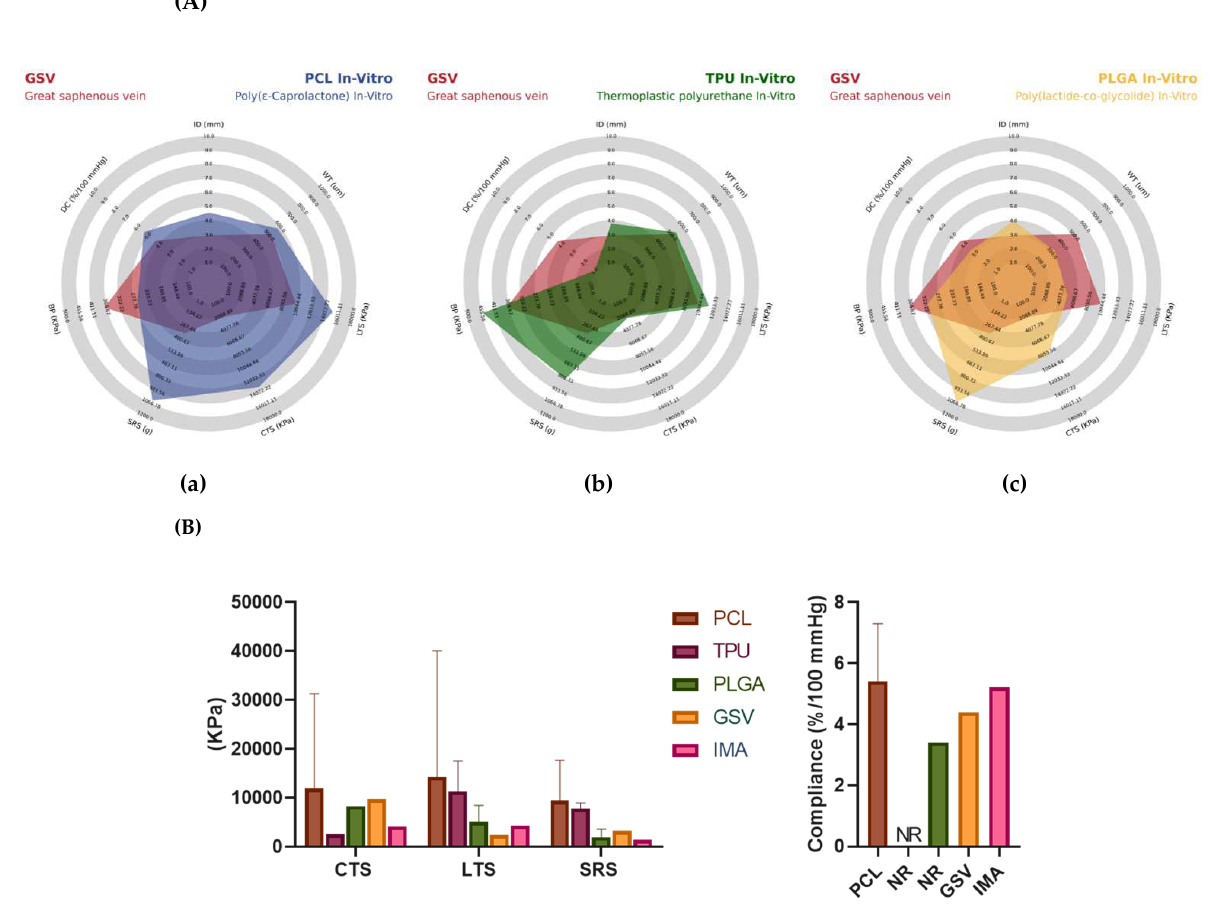
Figure 8. ( A ) Mechanical properties comparison of great saphenous vein, as a gold standard, ( a ) PCL, ( b ) TPU, and ( c ) PLGA tested in vitro. Mechanical properties identified include internal diameter (ID), wall thickness (WT), longitudinal tensile strength (LTS), circumferential tensile strength (CTS), suture retention strength (SRS), burst pressure (BP), and dynamic compliance (DC). Chart generated from the Python library developed by StatsBomb/Anmol Durgapal (accessed on 29 May 2022). ( B ) Mechanical properties comparison of great saphenous vein, as a gold standard, internal mammary artery and PCL, TPU, and PLGA subgroups of in vitro studies. Circumferential tensile strength (CTS), longitudinal tensile strength (LTS), suture retention strength (SRS), internal mammary artery (IMA), and great saphenous vein (GSV). Data are shown as mean ± standard deviation, according to the number of studies reporting the data. Additional information regarding descriptive analysis can be found on Table S3. Graph generated with GraphPad Prism (accessed on 29 May